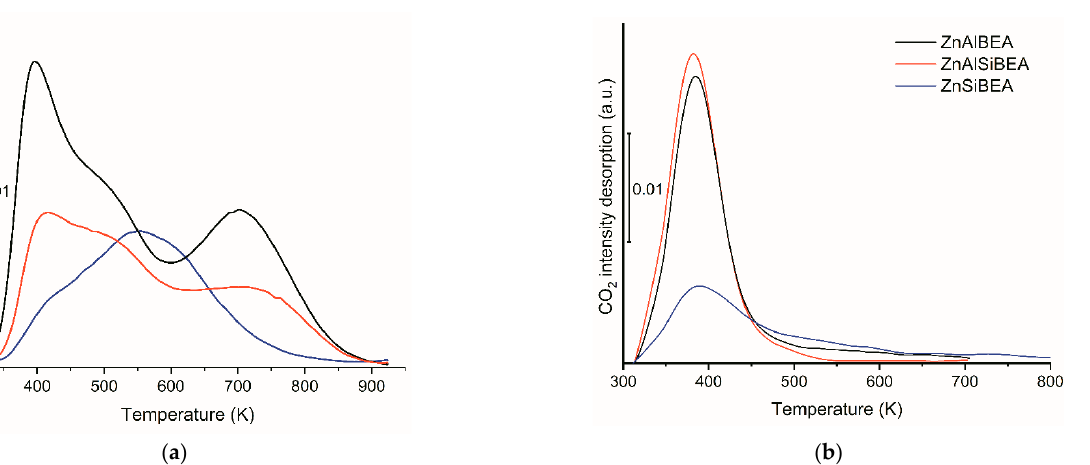
Figure 4. Normalized NH3-TPD ( a ) and CO 2 -TPD ( b ) profiles for the ZnAlBEA, ZnAlSiBEA, and ZnSiBEA compositions. Table 4. Acid–base characteristics of zeolite samples of Zn-BEA according to TPD-NH 3 (CO 2 ) pro- fi les.